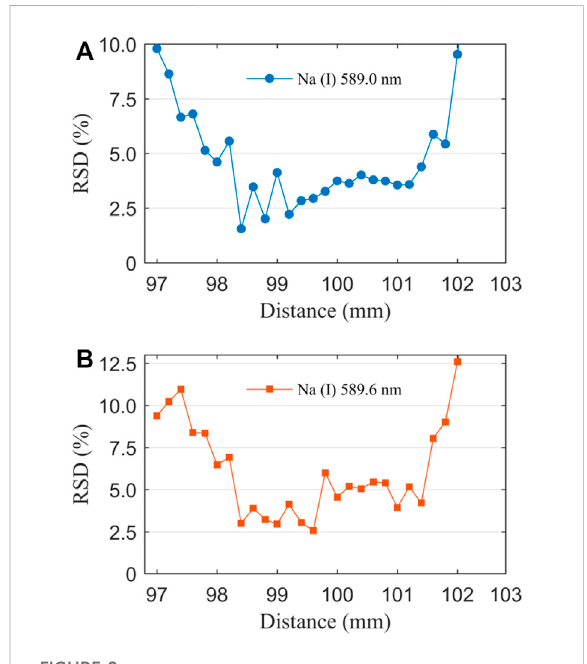
Evolution of RSD with DFLS for Na ( Ι ) 589.0 nm (A) and 589.6 nm (B) , the solute concentration is 4.00 μ